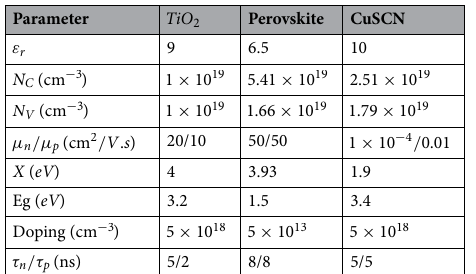
Table 2. The electrical parameters of the simulated